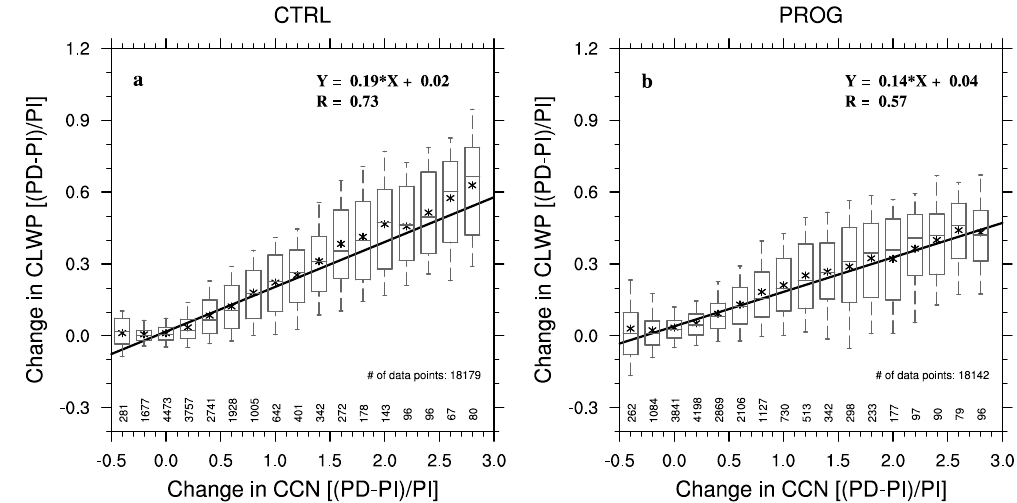
Figure 15. Box plots and linear regression lines of the relative changes [(PD − PI) / PI] in annual mean CLWP vs. the relative changes in annual mean activated CCN concentrations for the (a) CTRL and (b) PROG simulations, following the analysis by Wang et al. (2011). CCN concentrations are averaged over the lowest eight model levels (surface to about 800hPa). The boxes represent the median (middle line) and the 25th and 75th percentile (lower and upper line, respectively), of the data within that bin. The whiskers show the 10th and 90th percentile (lower and upper whisker, respectively), and the stars represent the mean. The numbers above the x axis represent the number of data points in a given bin. The linear regression lines and the Pearson correlation coefficients ( R ) are given in the right upper